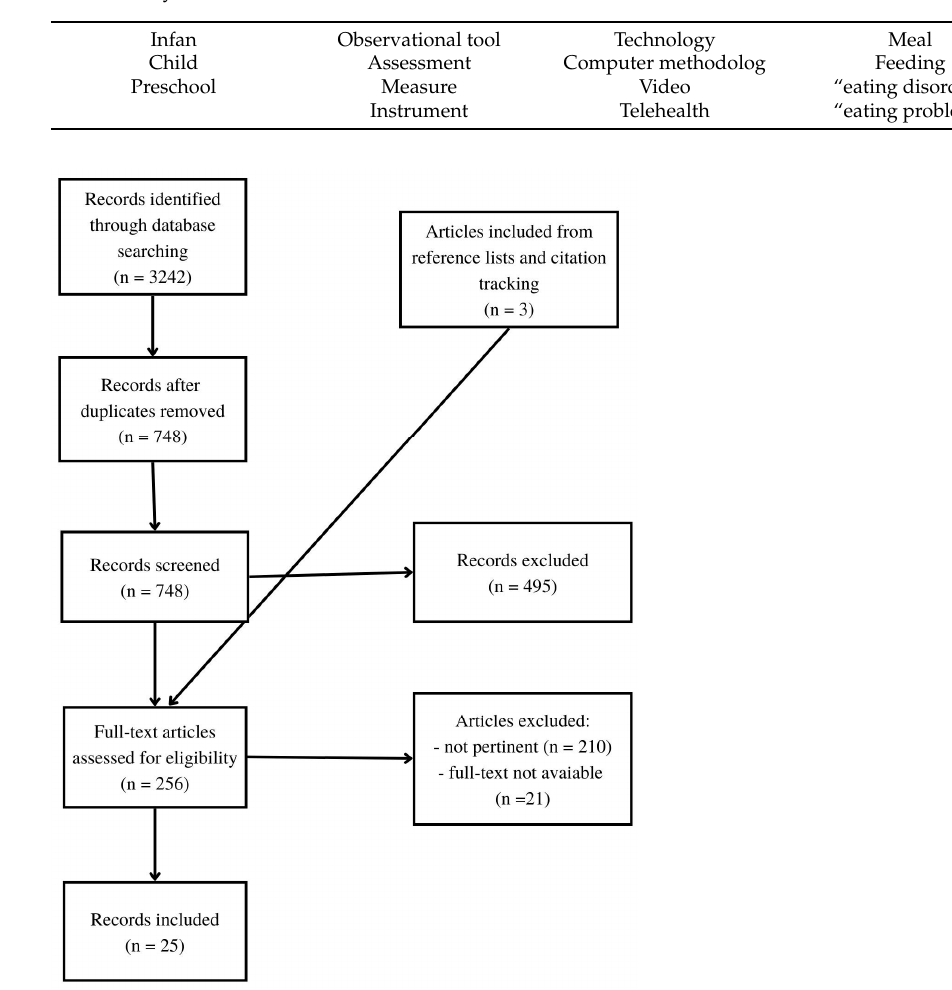
Figure 1. Figure 1. Flowchart.